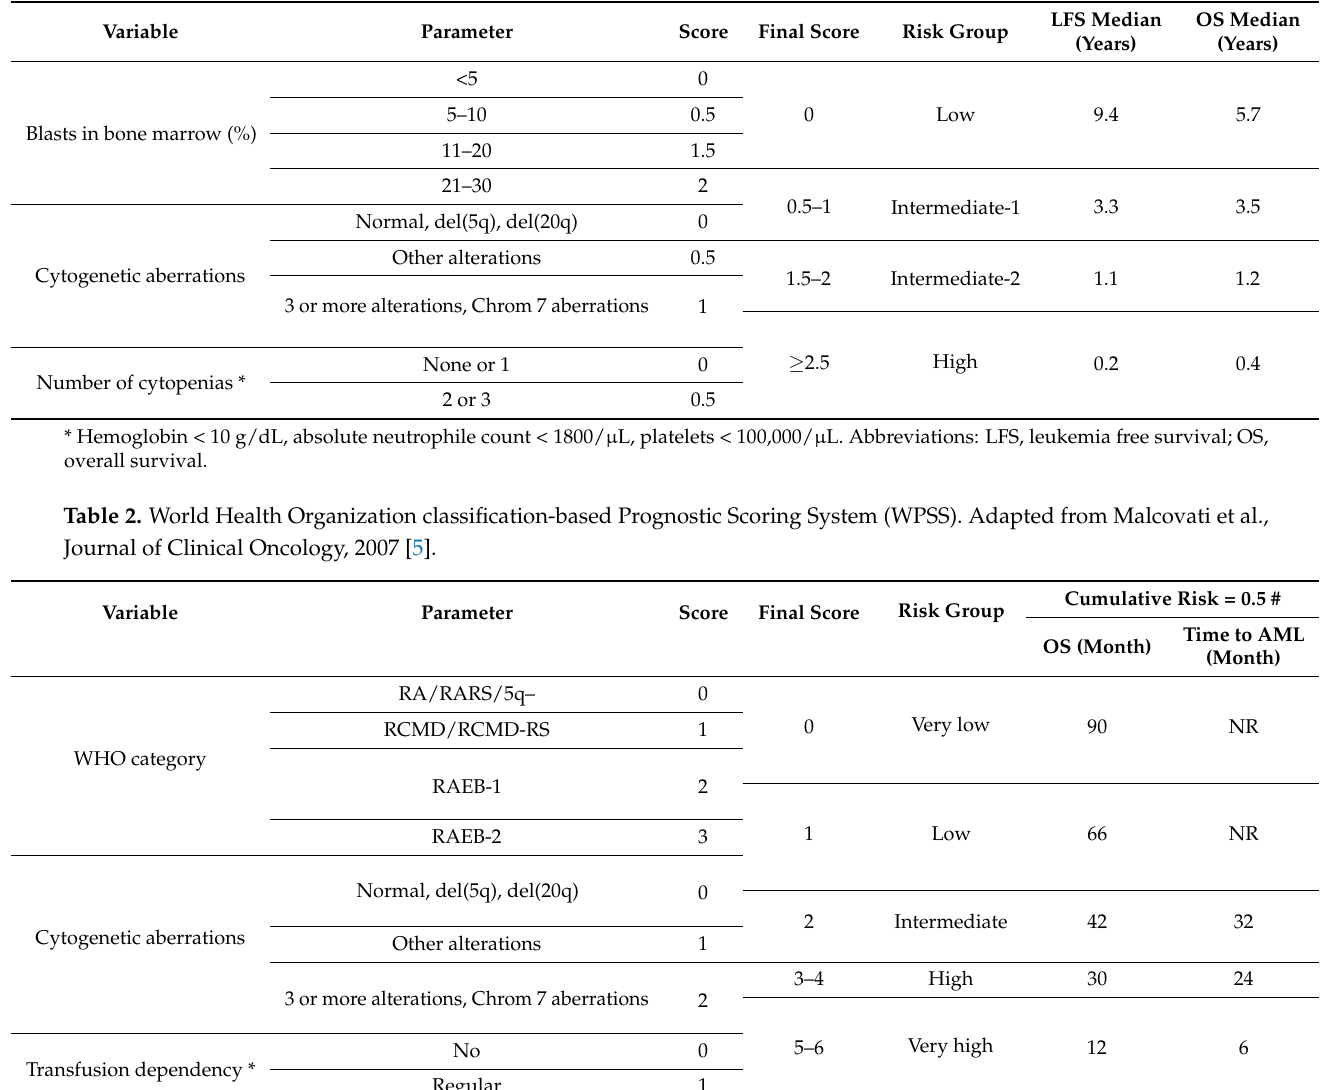
Table 1. International Prognostic Scoring System. Adapted from Greenberg et al., Blood, 1997 [1].